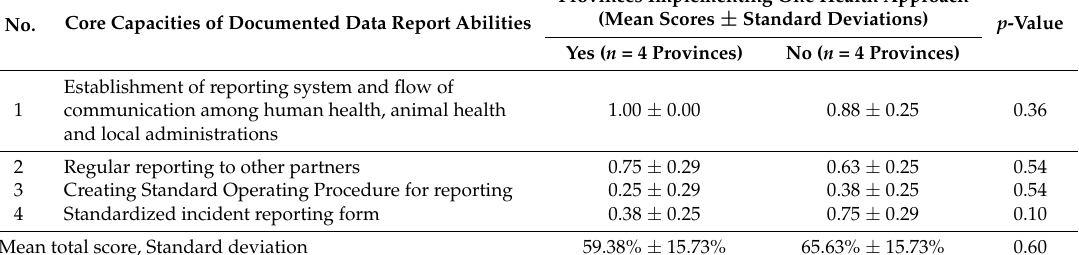
Table 3. Assessment of data report capacities between the provinces implementing One Health approach and not implemented One Health approach in Thailand, 2016.